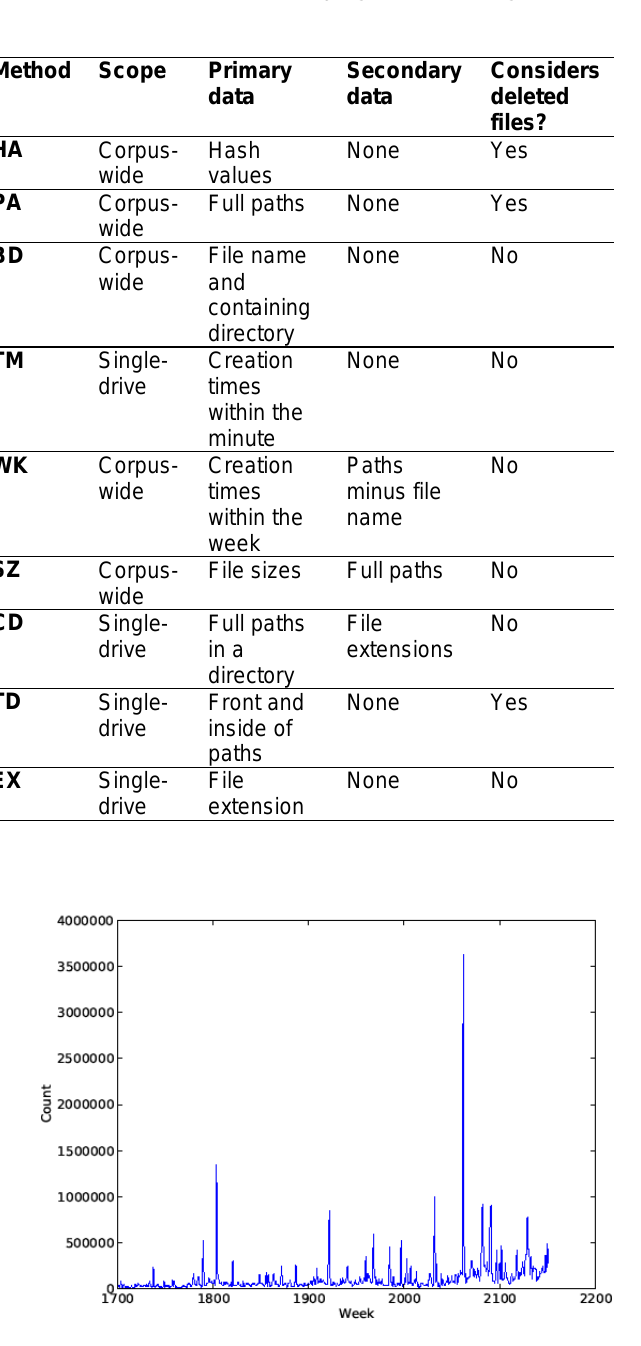
Table 3. Methods for identifying uninteresting files.